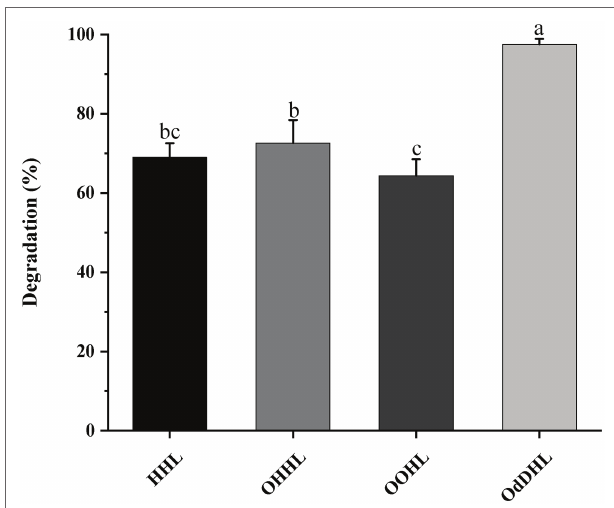
FIGURE 3 | The ability of strain W-7 to degrade different acyl homoserine lactone (AHL) signal molecules. HHL, N -hexanoyl-l-homoserine lactone; OHHL, N -(3-oxohexanoyl)-l-homoserine lactone; OOHL, N -(3-oxooctanoyl)-l- homoserine lactone; and OdDHL, N -(3-oxododecanoyl)-l-homoserine lactone. Statistical analysis was performed by one-way ANOVA of Duncan method, and different letters indicate significant differences ( p < 0.05) between